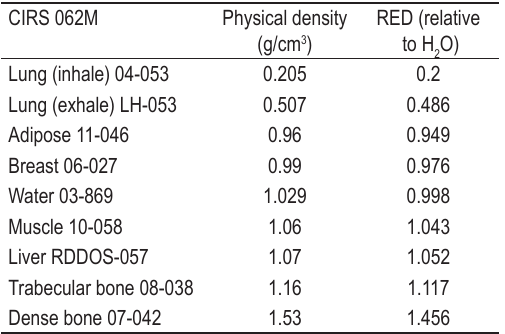
TABLE 1. CIRS 062M phantom relative electron and mass density data